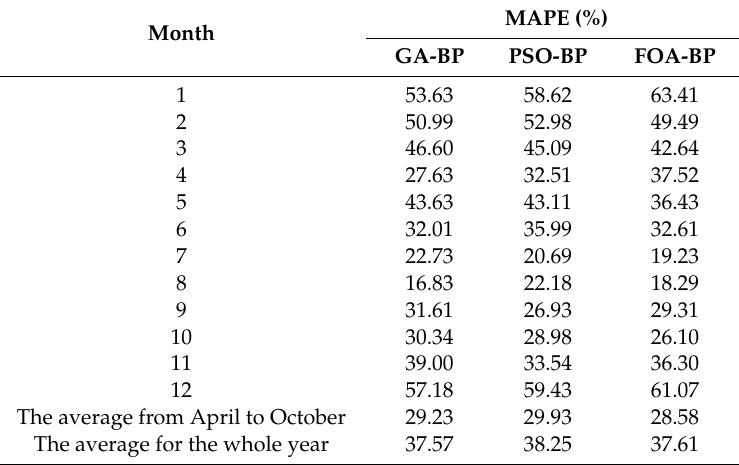
Table 4. Results of di ff erent models excluding the web search data.